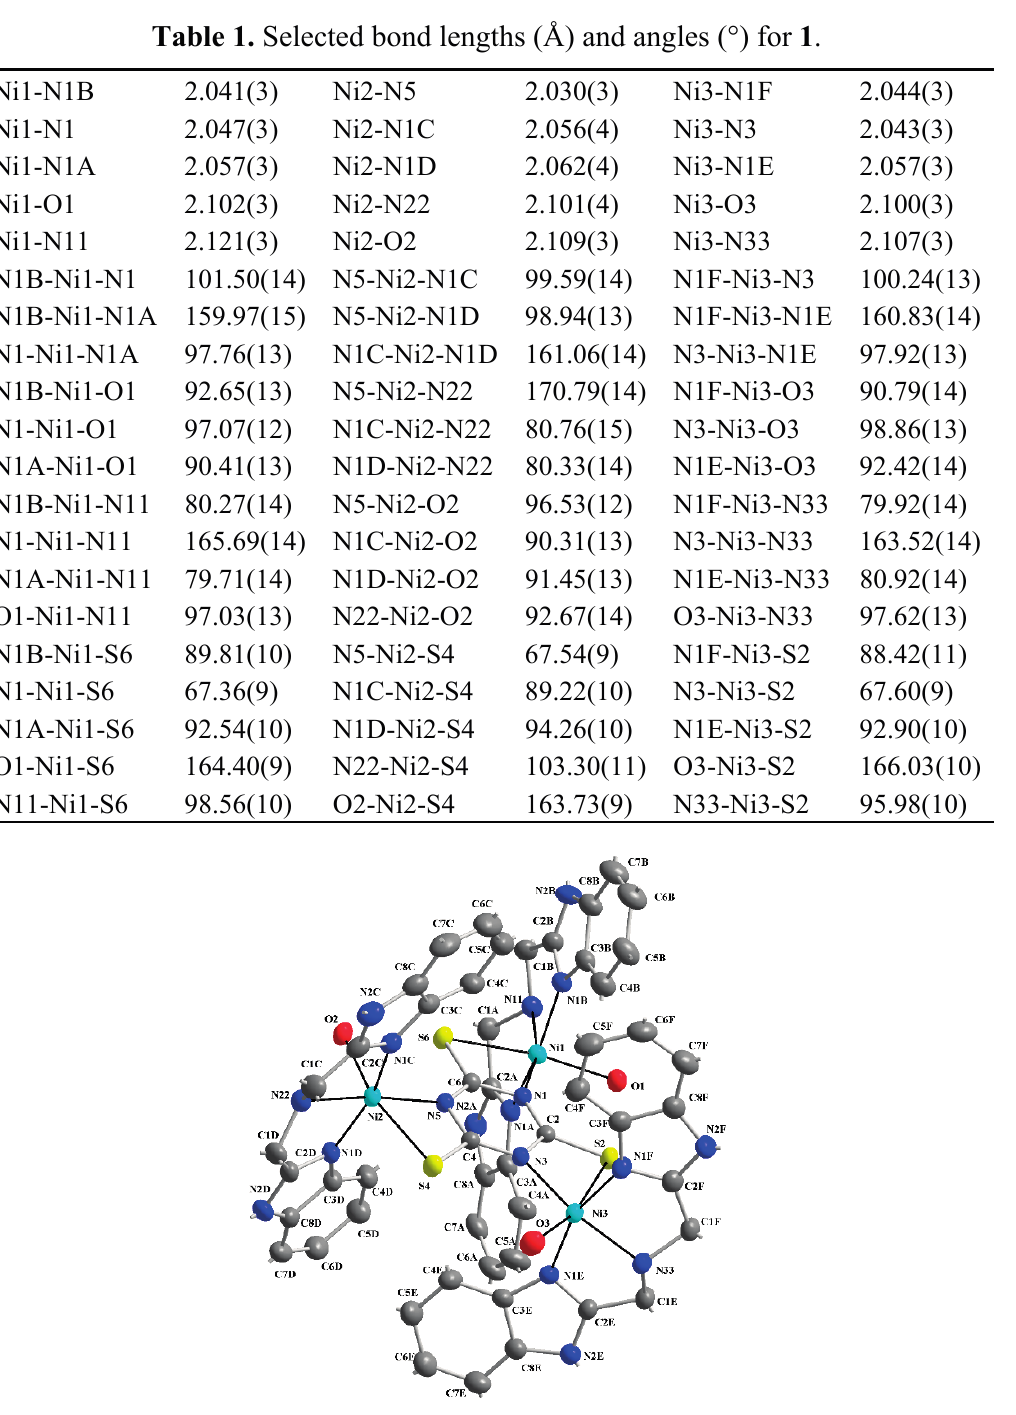
Figure 2. Numbering scheme of 1 with atomic displacement ellipsoids drawn at 30% probability level. Hydrogen atoms are omitted for